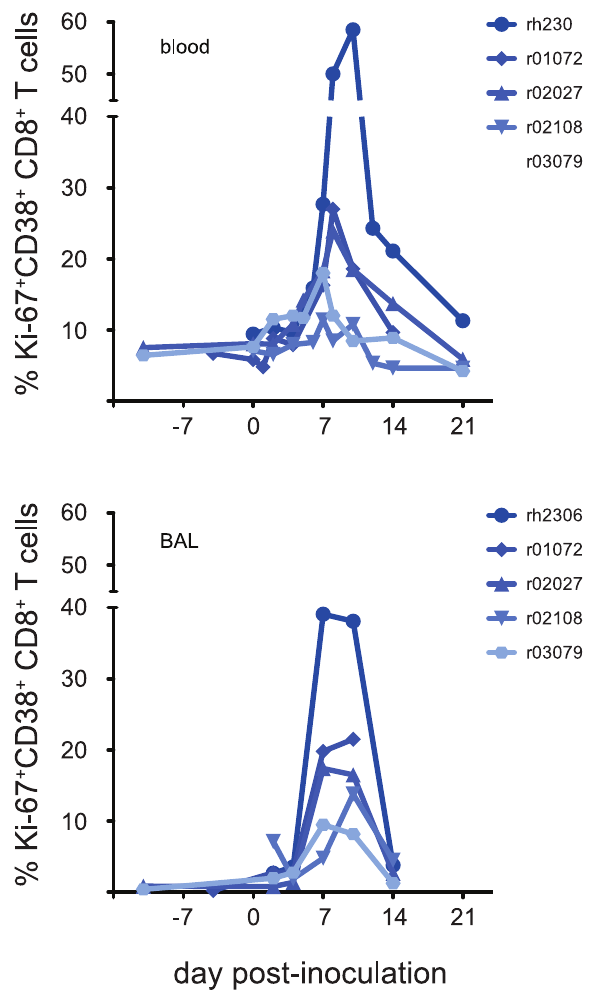
Figure 2. Activated CD8 + T cells appear in blood and lung within 7 days of inoculation with seasonal influenza virus K173. We used a flow cytometric assay to enumerate CD8 + T cells with an activated phenotype before and after K173 infection as described in the text. Data plotted are the frequency of CD3 + CD8 + lymphocytes that express both Ki-67 and CD38. Data are not available from animal r01072 at day 21 post-inoculation due to technical problems.